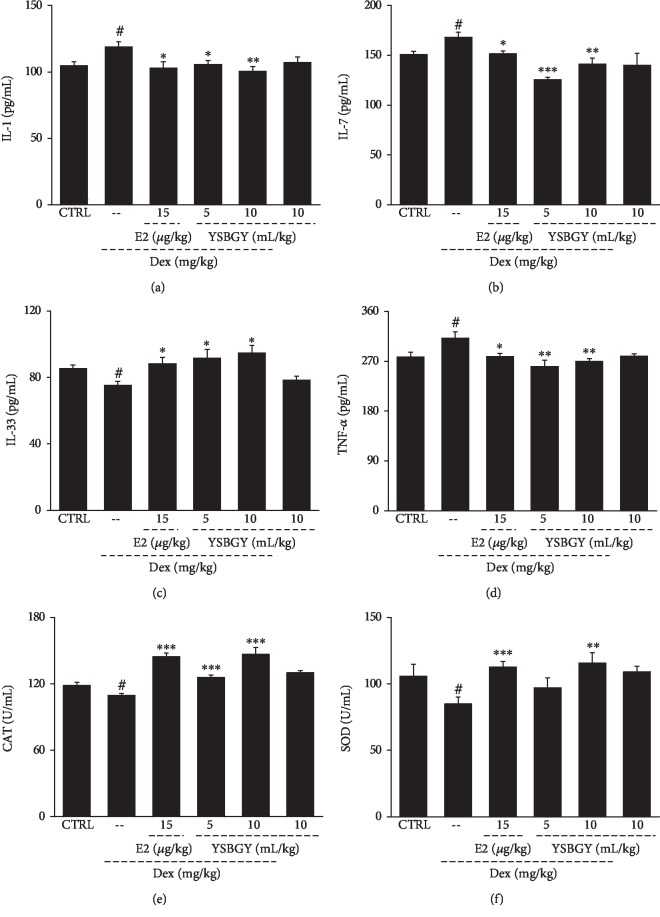
Regulation of the serum levels of inflammatory cytokines in OP mice by YSBGY. YSBGY reduced the serum levels of (a) IL-1, (b) IL-7, and (d) TNF-α and increased those of (c) IL-33, (e) CAT, and (f) SOD in OP mice. Data are expressed as means ± SEM (n = 10) and analyzed using a one-way ANOVA. #P < 0.05vs. control mice; ∗P < 0.05, ∗∗P < 0.01, and ∗∗∗P < 0.001vs. OP mice.